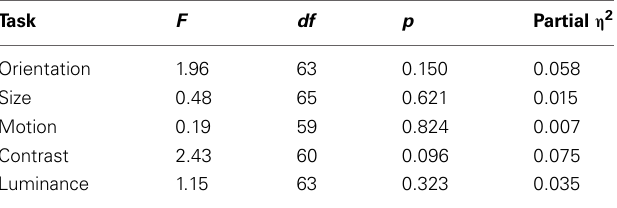
Table 3 | Results of ANOVAs comparing contextual effects of schizophrenia, bipolar, and control groups in each task.